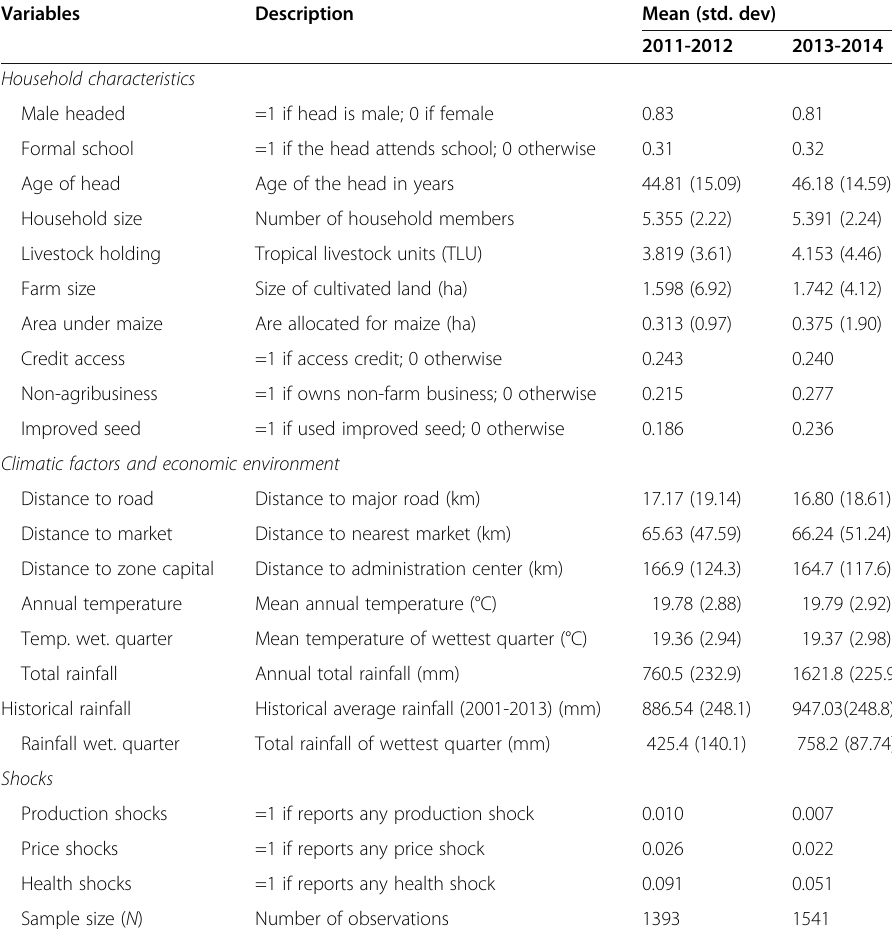
Table 1 Description and summary of the variables used in the econometric models